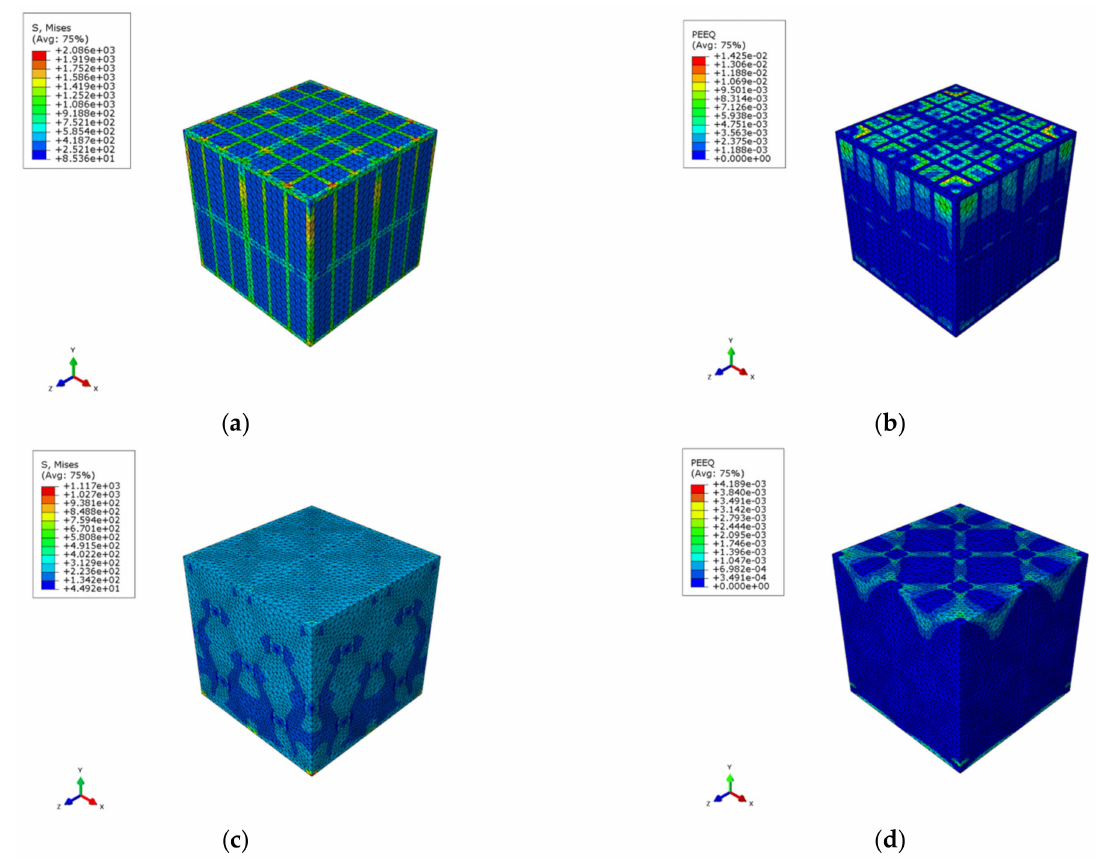
Figure 12. The FE analysis of the Cu-W composites with cubic ( a , b ) and rhombic dodecahedron- skeletons ( c , d